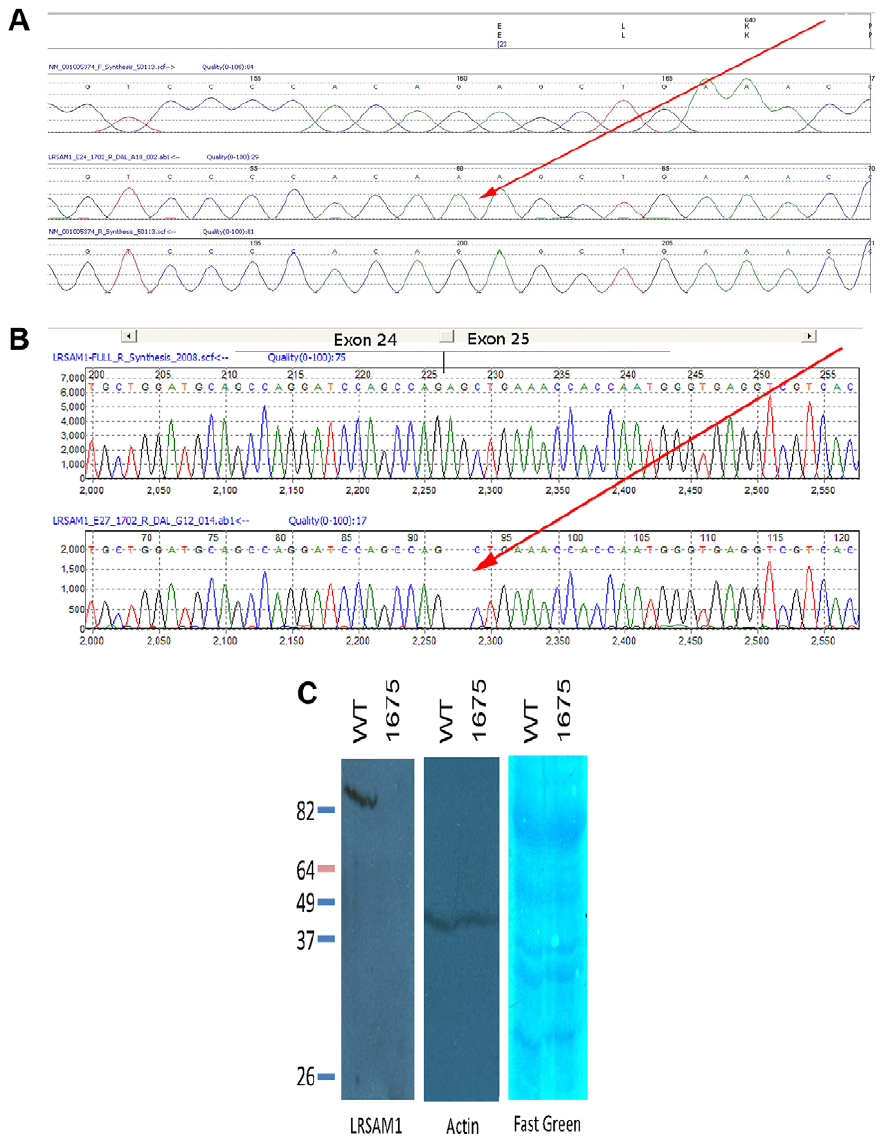
Figure 2. Sequence showing mutation in genomic and cDNA of affected patient. (A) Mutation of splice acceptor site AG of LRSAM1 exon 24 (25 in alternative isoform 3) to dinucleotide AA in genomic DNA of patient 1702. Upper to lower panels: translation of coding exon; virtual chromatogram of consensus genomic sequence forward direction; sequence chromatogram of affected patient reverse direction; virtual chromatogram of consensus genomic sequence reverse direction. Red arrow points to homozygous mutation. (B) Sequence of cDNA from RNA of patient 1702 showing aberrant splice site utilization and frameshift of encoded protein. Upper panel, sequence chromatogram of correctly spliced cDNA from exon 24 to 25 (per isoform 3); lower panel, sequence chromatogram of incorrectly spliced cDNA from affected patient. Two base deletion caused by splicing interior to exon 25 (red arrow). (C) Western blot of LRSAM1 protein in cells cultured from patient homozygous for LRSAM1 mutation. EBV-transformed B- lymphocytes from control or patient 1675 were extracted and Western blotted with anti-LRSAM1 antibody. Left, anti- LRSAM1; center, anti-actin; right, Fast green total protein stain. doi:10.1371/journal.pgen.1001081.g002 Data are generated in three different output formats, AB, Forward strand, and Top strand (as defined by Illumina). We used AB format for all linkage analyses.